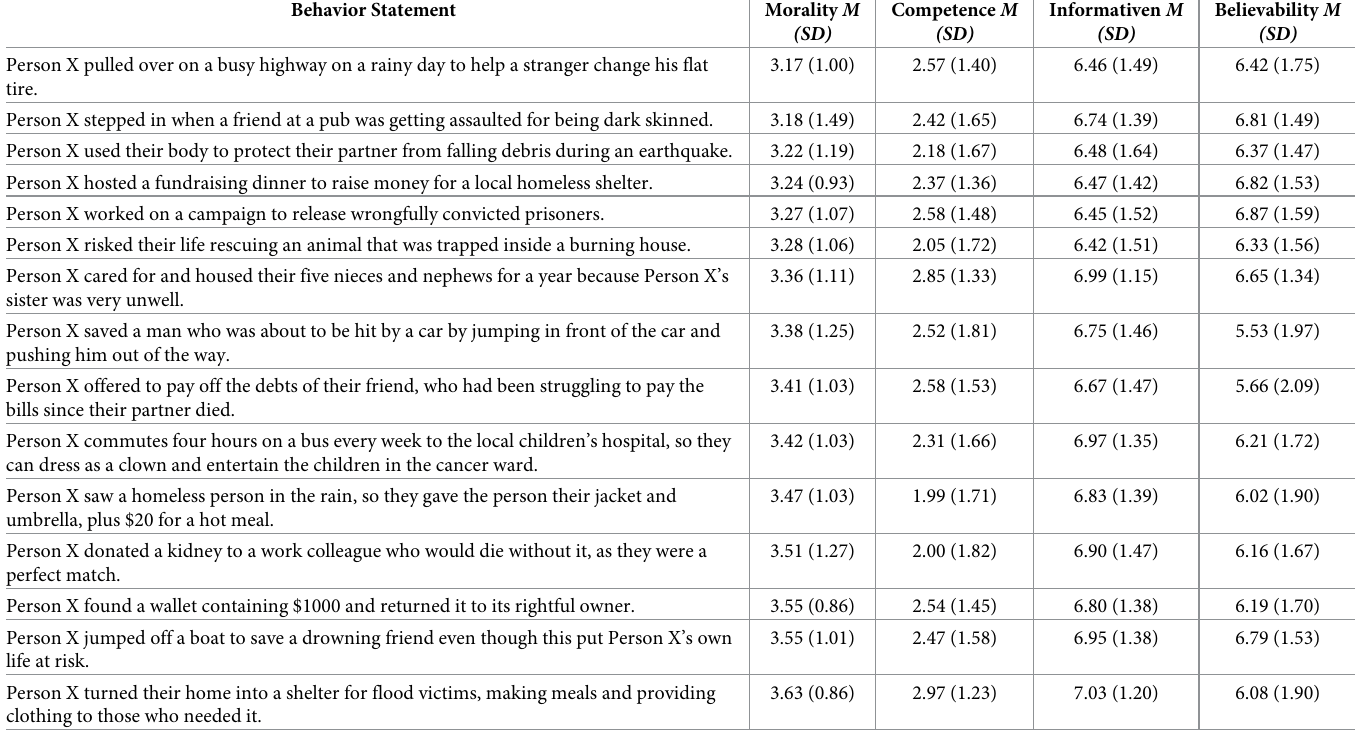
There were moderate-to-strong Pearson correlations between the morality and competence ratings, the morality and believability ratings, the competence and believability ratings, and the informativeness and believability ratings (see Fig